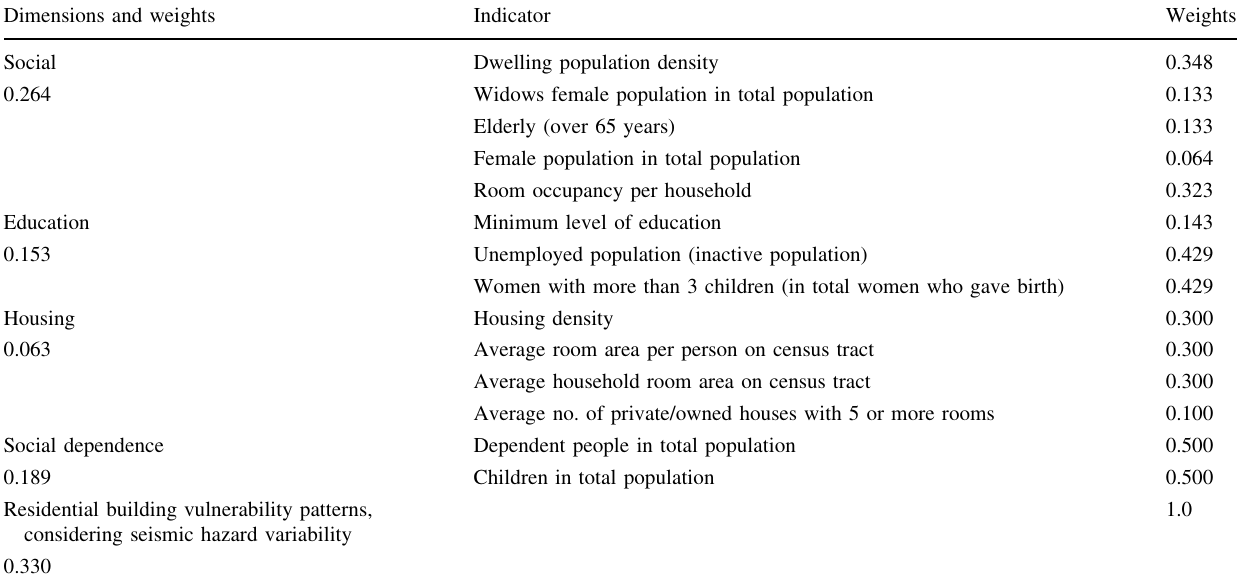
Table 3 Normalized weights of social, educational, housing, and social dependence indicators Dimensions and